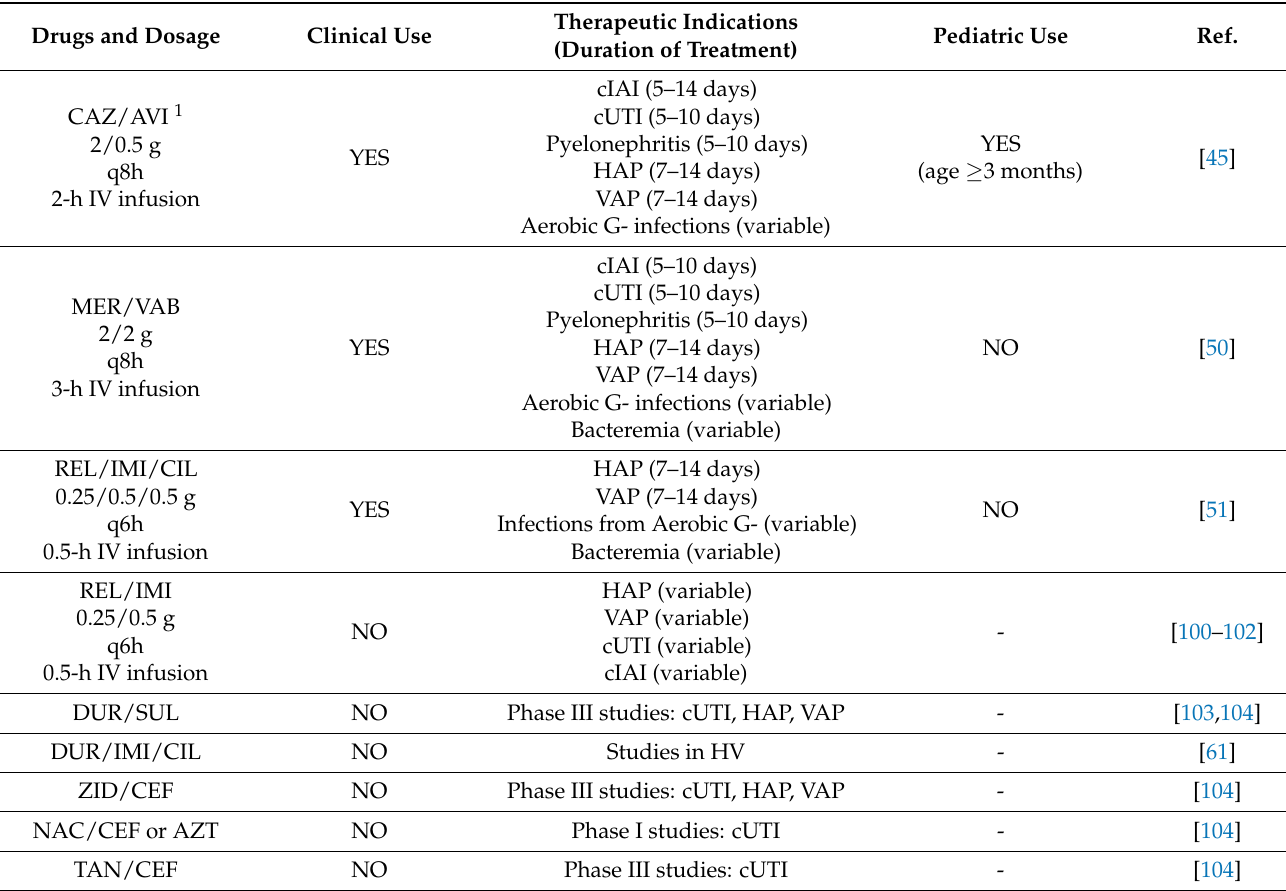
Table 3. β -lactam plus BLI combinations registered for clinical use in Europe or in clinical evaluation for the treatment of several